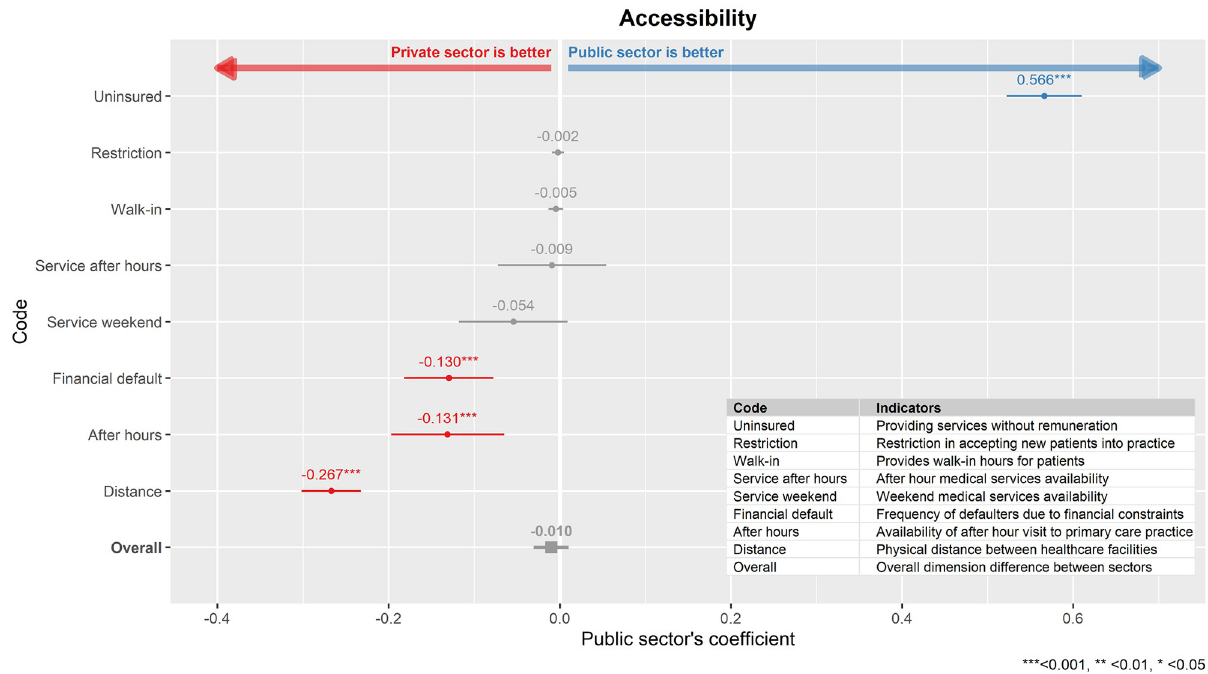
Fig 1. Comparison between public and private primary care clinics in the dimension of accessibility. The public sector’s regression coefficient ( β public ) for each indicator model as well as overall dimension model was shown here together, with its 95% confidence